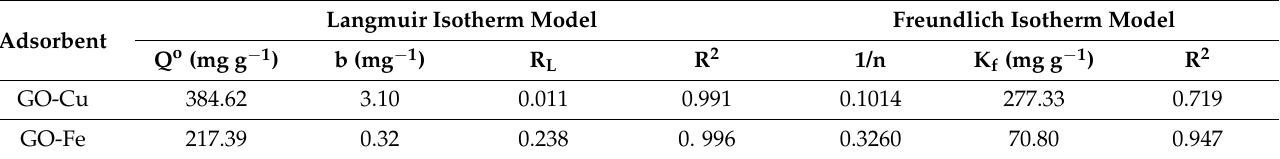
Figure 6. Effect of ( a ) dye concentration on removal percent, ( b ) Langmuir isotherm plot, ( c ) R L plot and ( d ) Freundlich isotherm plot of MB-dye using GO@Cu (t = 5 min, Dose = 5 mg, V = 50 mL, pH = 7, T = 25 ◦ C) and GO@Fe (t = 5 min, Dose = 6 mg, V = 50 mL, pH = 7, T = 25 ◦ C) form aqueous solution. Table 3. Langmuir and Freundlich constants for adsorption of MB-dye using GO@Cu (t = 5 min, Dose = 5 mg, V = 50 mL, pH = 7, T = 25 ◦ C) and GO@Fe (t = 5 min, Dose = 6 mg, V = 50 mL, pH = 7, T = 25 ◦ C) form aqueous solution.